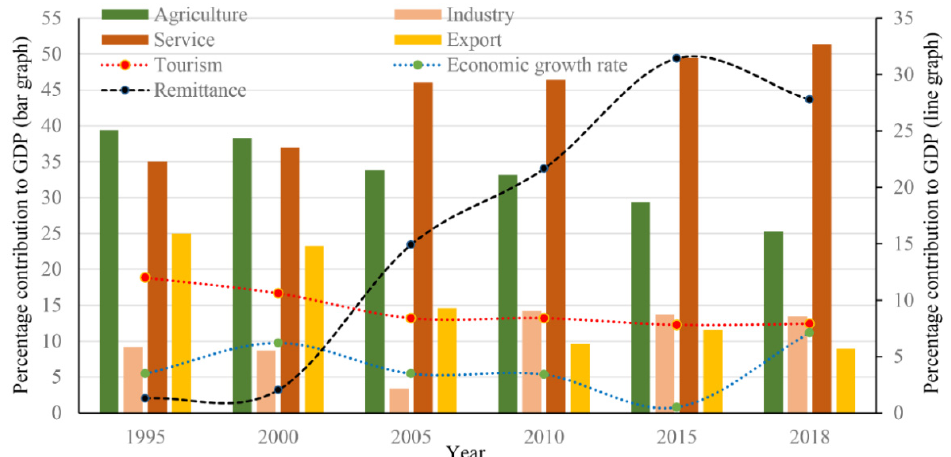
Figure 8. Contribution of agriculture, service, industry, tourism, and remittance to the gross domestic products (GDP) and the snail’s pace of economic growth (Sources: [37,41–46]). Large-scale employment is not possible without industrialization and expanding service sectors.